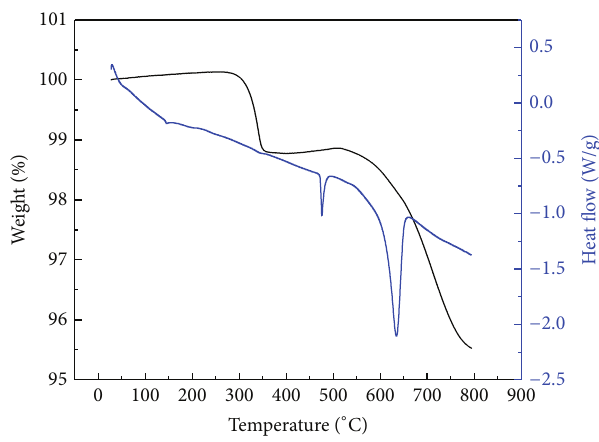
Figure 2: DSC-TGA graph of Alumix 431D